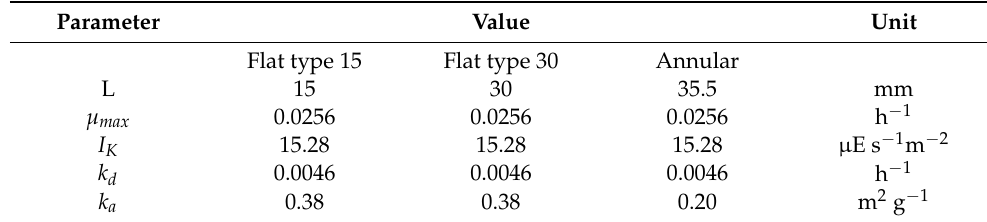
Table 2. Data and parameters employed for the model.